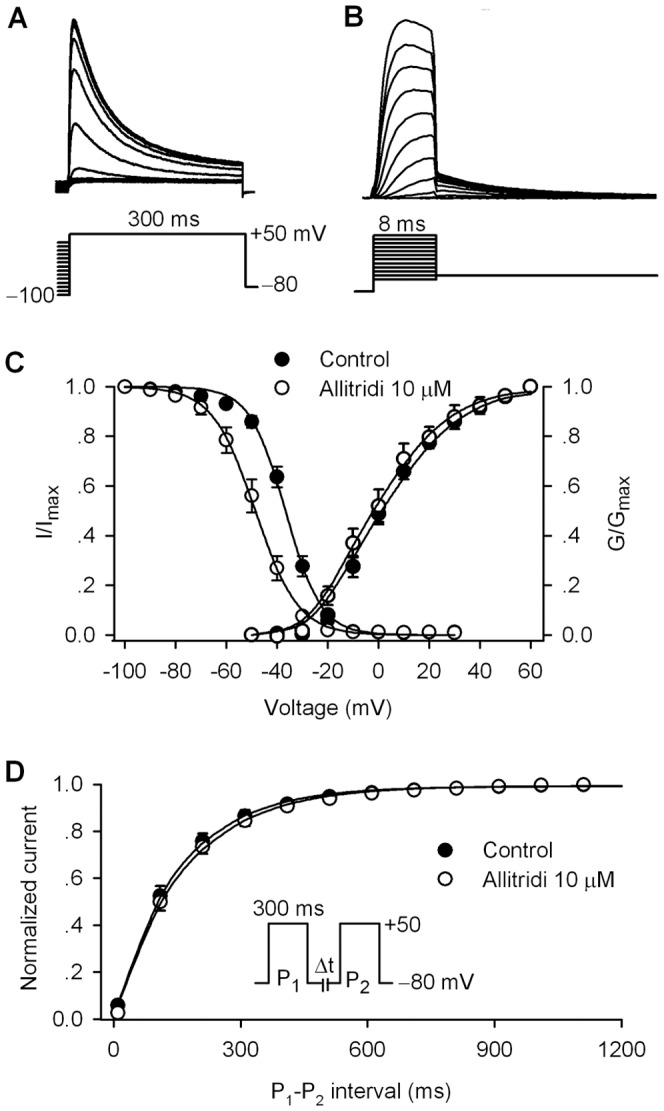
Effect of allitridi on kinetics of hKv4.3 current.
A. Protocol and current traces used to assess availability (I/Imax, steady-state inactivation) of hKv4.3 current. B. Protocol and tail current traces used to assess activation conductance (G/Gmax, steady-state activation) of hKv4.3 current. C. Mean values of hKv4.3 current (I/Imax) variables and conductance (G/Gmax) variables before and after 10 µM allitridi were fitted to the Boltzmann function: g = 1/(1+exp((V1/2-Vt)/K)), where V1/2 is the voltage of 50% channel availability or maximal activation of the channel, Vt is the test potential, and K is slope factor. C. Mean values of recovery time course of hKv4.3 current from inactivation, determined with protocol as shown in the inset before and after 10 µM allitridi, were fitted to a mono-exponential function.